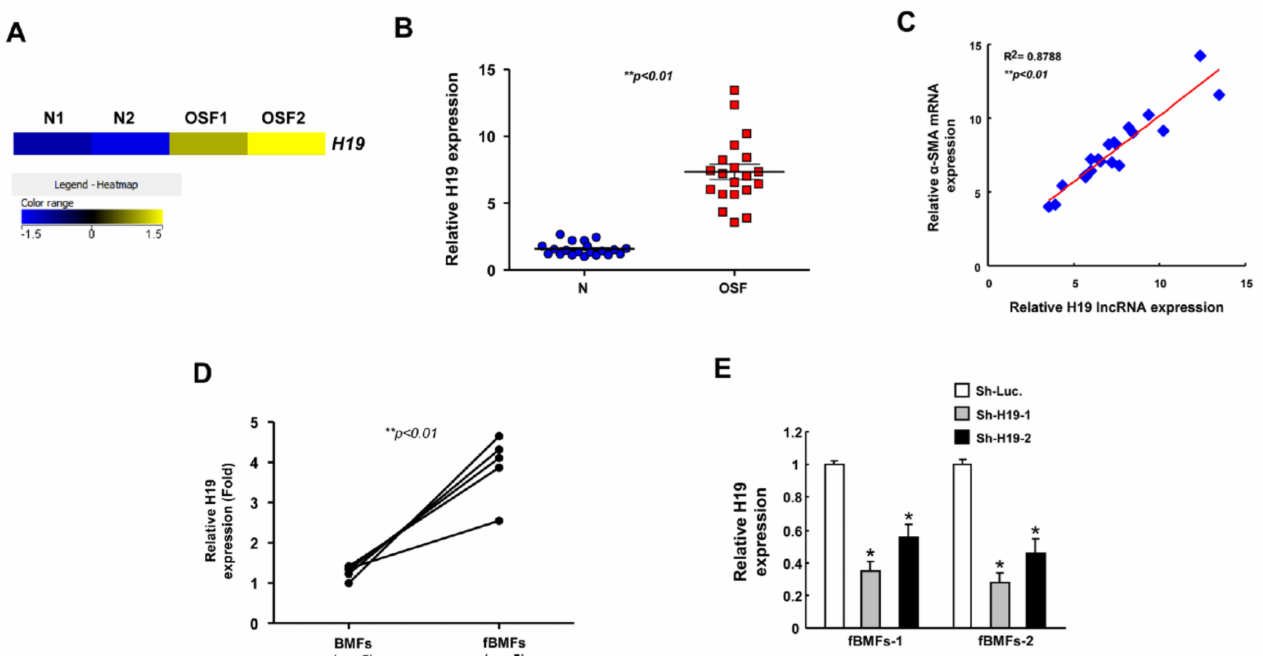
Figure 1. The expression of H19 is aberrantly upregulated in oral submucous fibrosis (OSF) tissues. ( A ) Heatmap represen- tation of differentially expressed genes between normal ( n = 2) and OSF tissues ( n = 2). ** p < 0.01 ( B ) qRT-PCR analysis showing lncRNA expression of H19 in normal ( n = 20; blue dots) and OSF tissues ( n = 20; red dots). ( C ) Positive correlation between myofibroblast marker smooth muscle actin (SMA) and H19 in OSF tissues (blue dots). ( D ) RT-PCR analysis of the expression level of H19 in fBMFs (fibrotic buccal mucosal fibroblasts) and BMFs (buccal mucosal fibroblasts) extracted from OSF and normal counterparts, respectively; ** p < 0.01 compared with normal BMFs. ( E ) Knockdown efficiency of lentivirus-mediated short hairpin RNA (shRNA) targeting H19 in two patient-derived fibrotic buccal mucosal fibroblasts (fBMFs). * p < 0.05 compared to sh-Luc